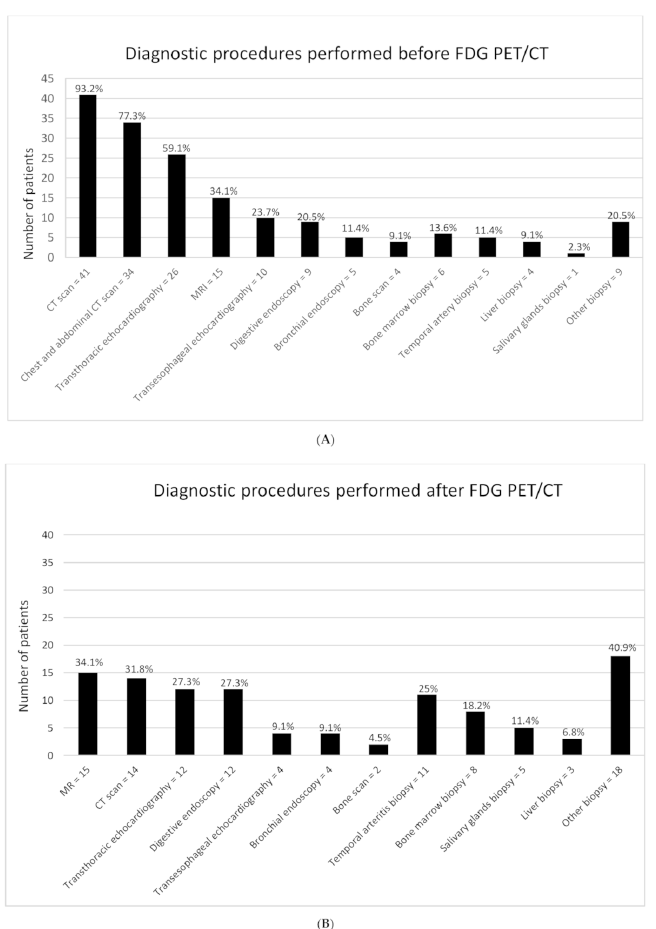
Figure 2. ( A ) Investigations that have been realized before 18 F-FDG-PET/CT; ( B ) Investigations that have been realized after 18